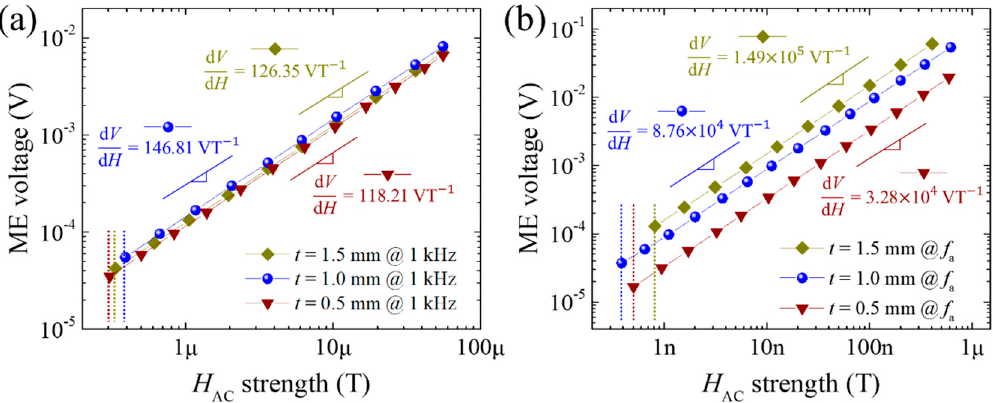
Figure 8. Magnetoelectric voltage output as a function of H AC of PZT-PMS sensors with different FE layer thicknesses (FE areal dimensions: 13.5 mm ( l ) × 3.0 mm ( w )): ( a ) measured at 1 kHz and ( b ) measured at an anti-resonance frequency of the sensors. Slope values and dashed lines indicate magnetic field sensitivities and observed sensing limits, respectively.